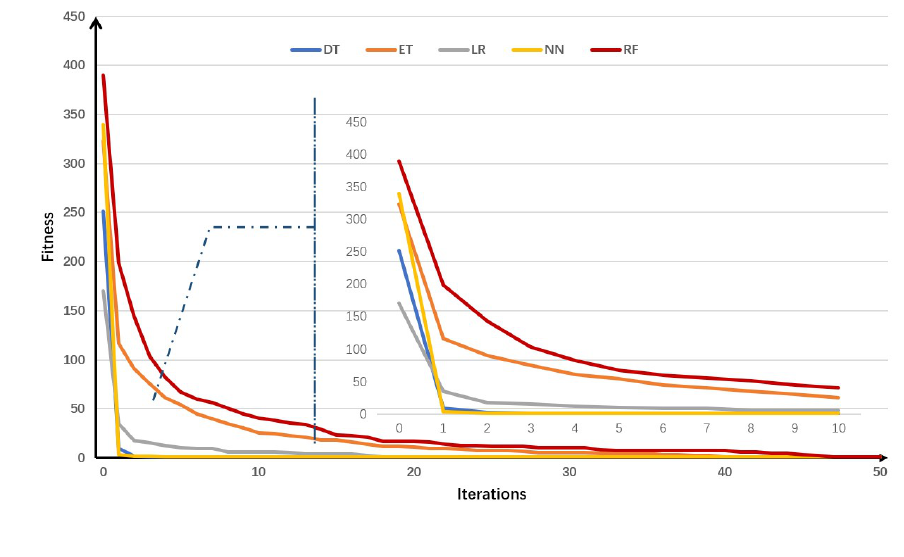
Figure 4. Trend graph of fitness function values with number of